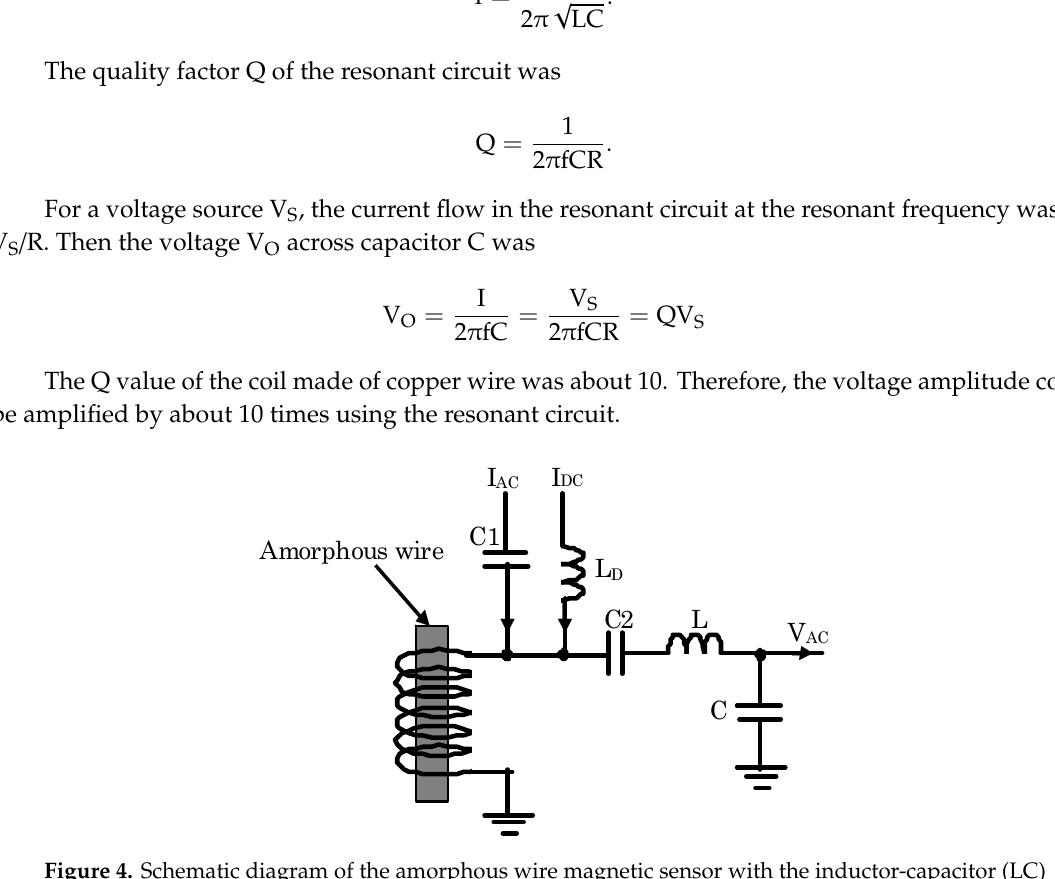
Figure 5. Equivalent circuit of the resonant circuit.